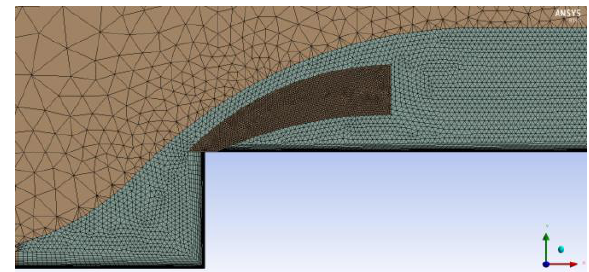
Fig. 9. Cell structure of the final three-dimensional numerical model (at the leading edge).